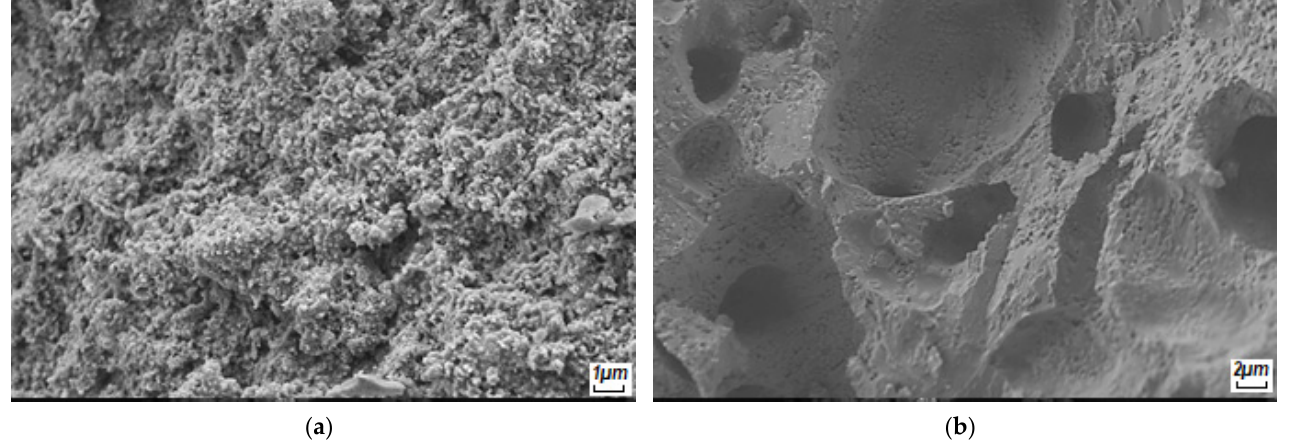
Figure 5. SEM images of the ceramic samples obtained from pre-ceramic samples based on the hydroxyapatite powder and the aqueous solution of sodium silicate after heat treatment at 700 °C ( a ) and 1100 °C ( b ).